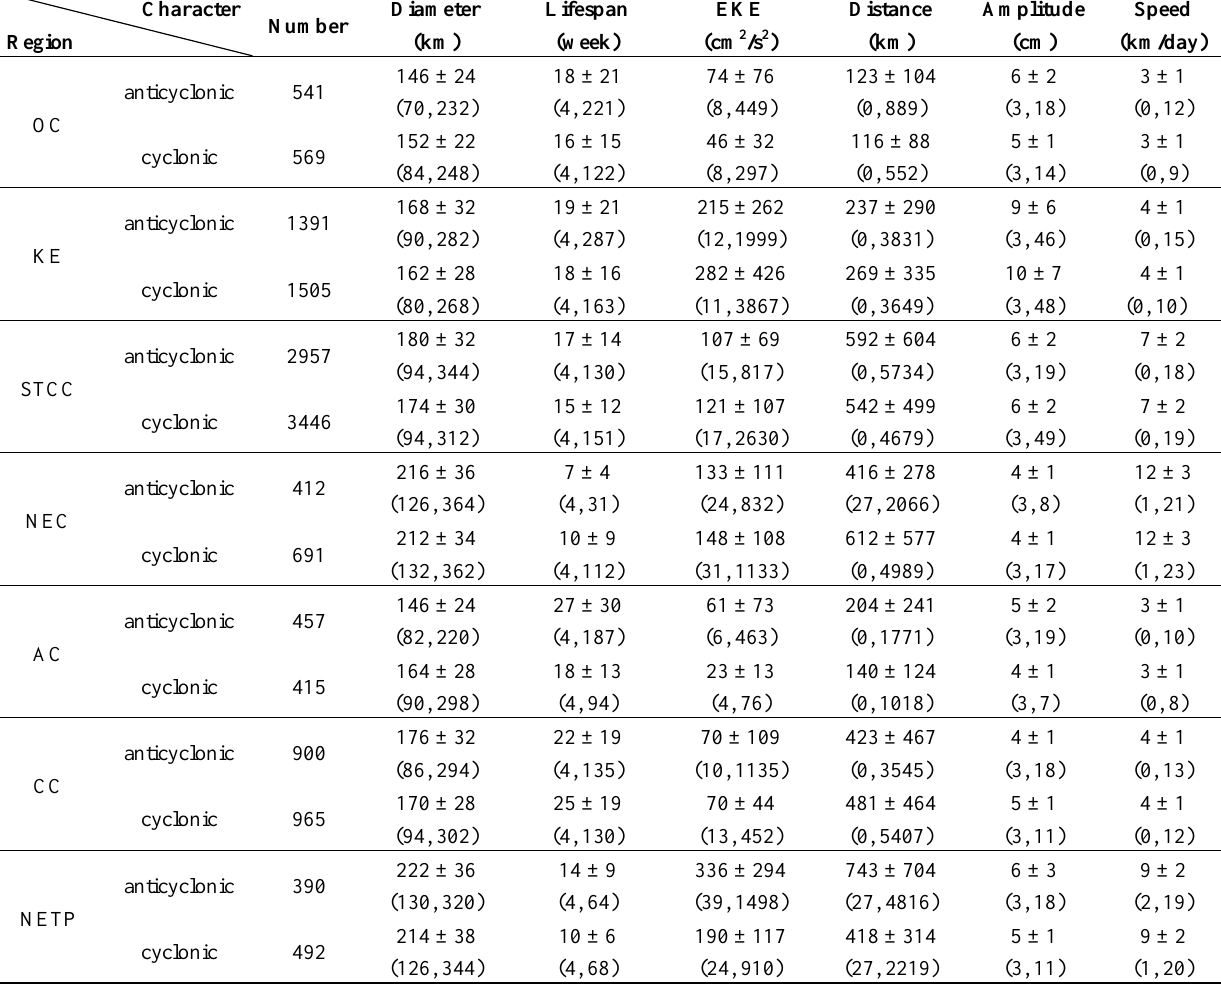
Table 1. Statistics of eddy kinematic properties in seven regions of the North Pacific a from 1992 to 2012 (Mean ± One Standard Deviation).